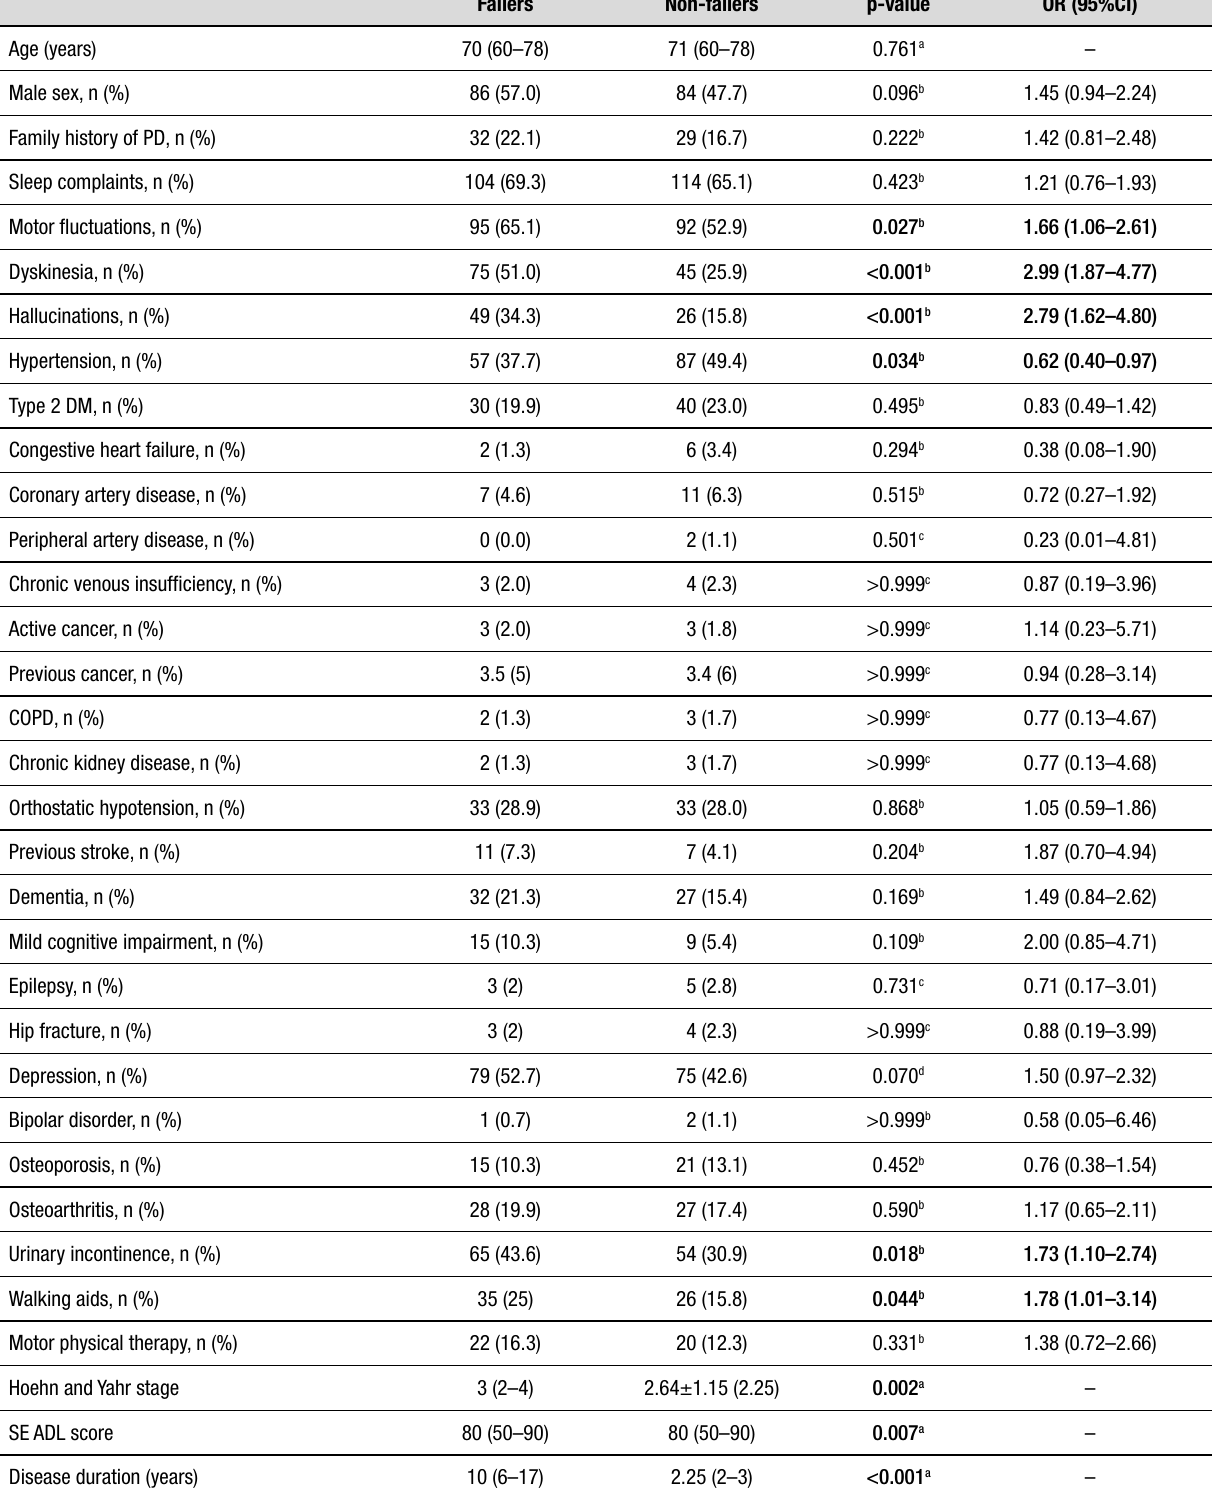
Table 1. Sociodemographic and clinical characteristics of fallers and non ‑fallers among patients with Parkinson’s disease. Fallers Non ‑fallers p ‑value OR